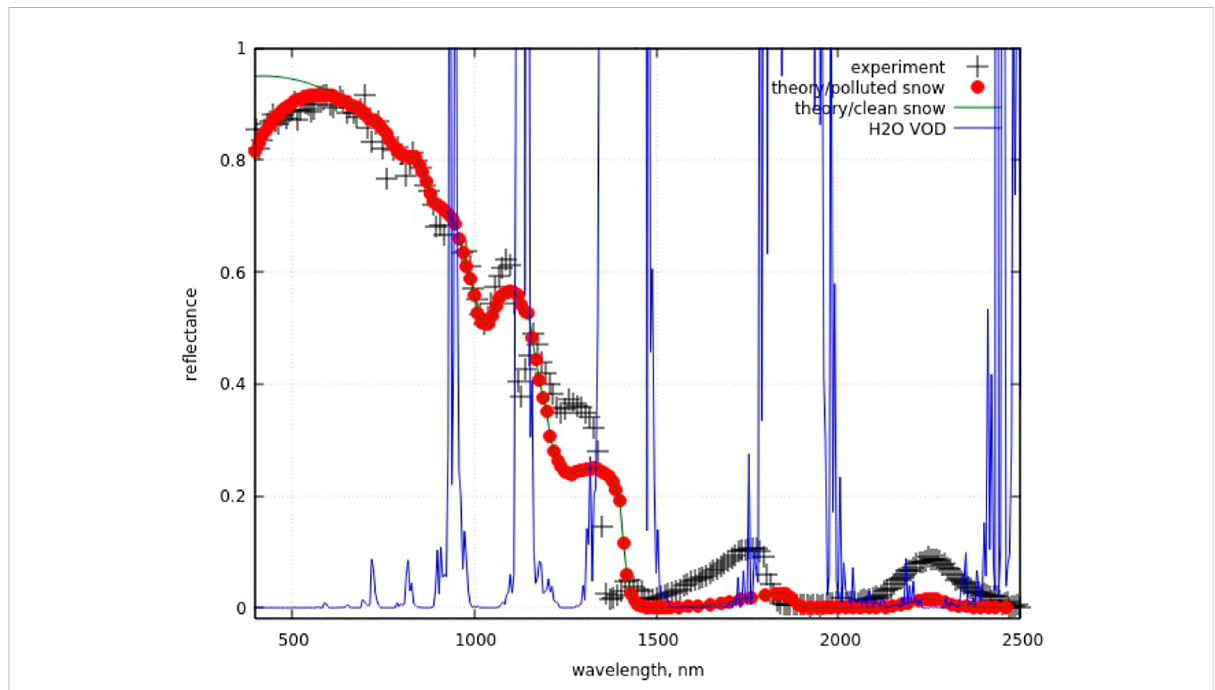
FIGURE 4 Comparison oftheoryandexperimentaldataforthewholemeasuredspectralrange(forthecase1inTable3).Wealsoshow theverticaloptical depth of water vapor (courtesy of L. Lelli). The solid line corresponds to the calculation in the absence of snow impurities (pure snow).